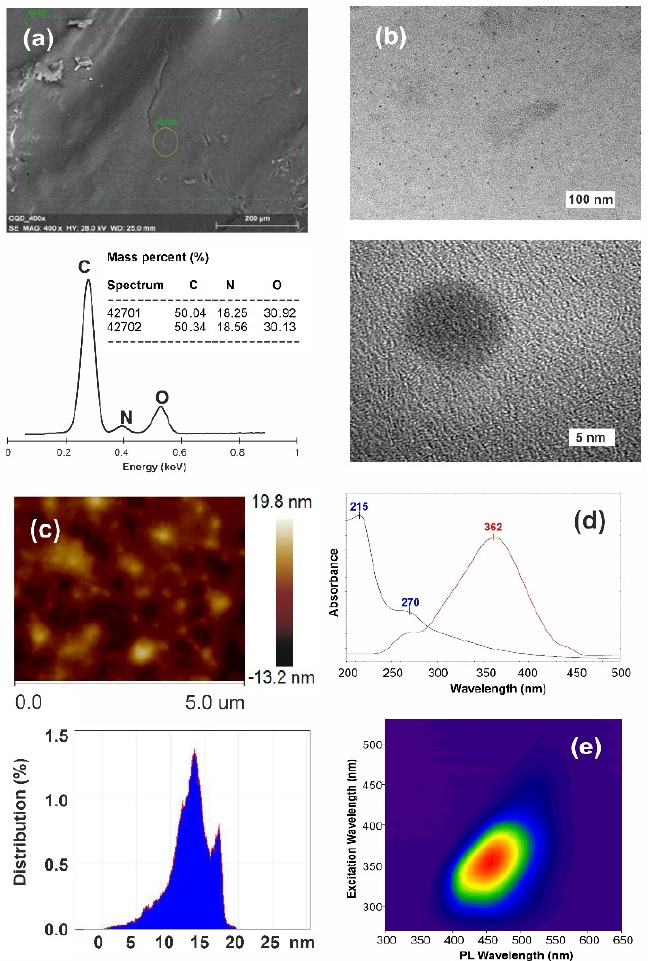
Figure 2. Characteristics of as-obtained N-CQDs: ( a ) elemental analysis based on EDX measurements, ( b ) HRTEM images, ( c ) AFM image with particle size distribution, ( d ) UV–Vis absorption spectrum (blue) and fluorescence excitation (red, λ em = 450 nm), and ( e ) 2D fluorescence topographical map of the N-CQD.